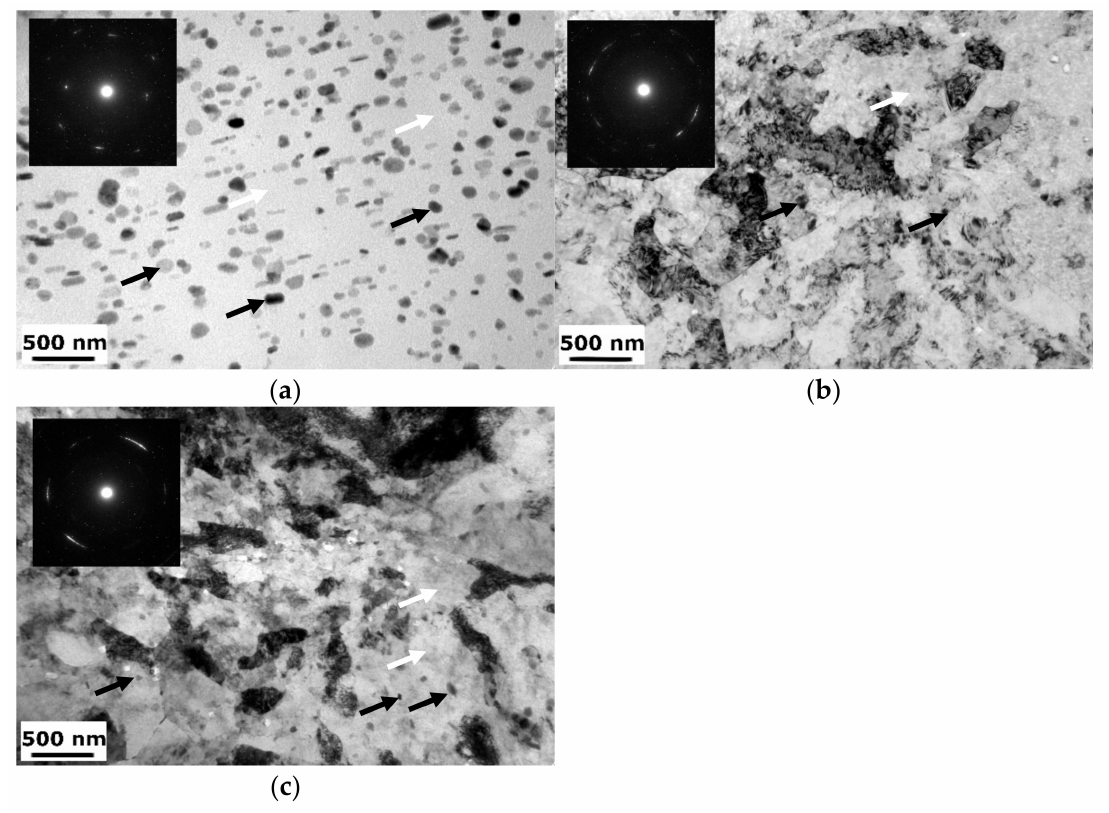
Figure 7. TEM micrographs of the: ( a ) CG T6, ( b ) HE10 HT2, and ( c ) HE8 HT2 samples, black arrows indicate η precipitates, white arrows— η (cid:48)